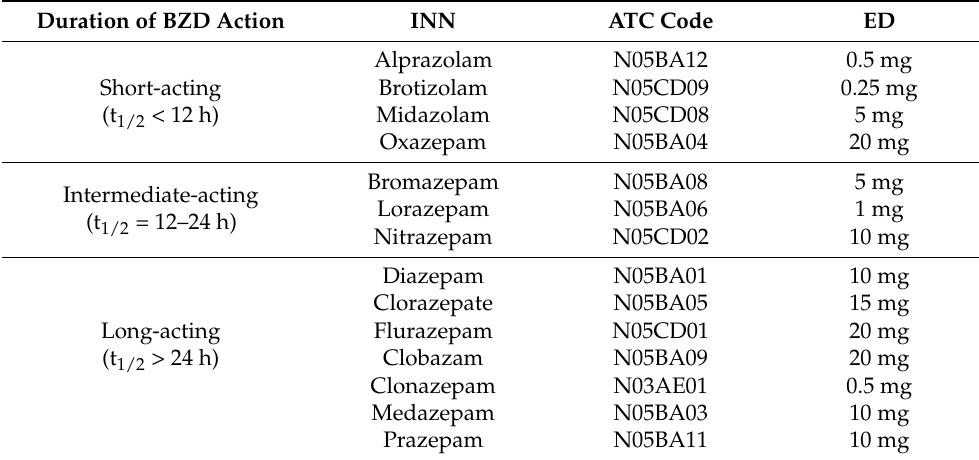
Table 1. Duration of action and equivalent doses of benzodiazepines.